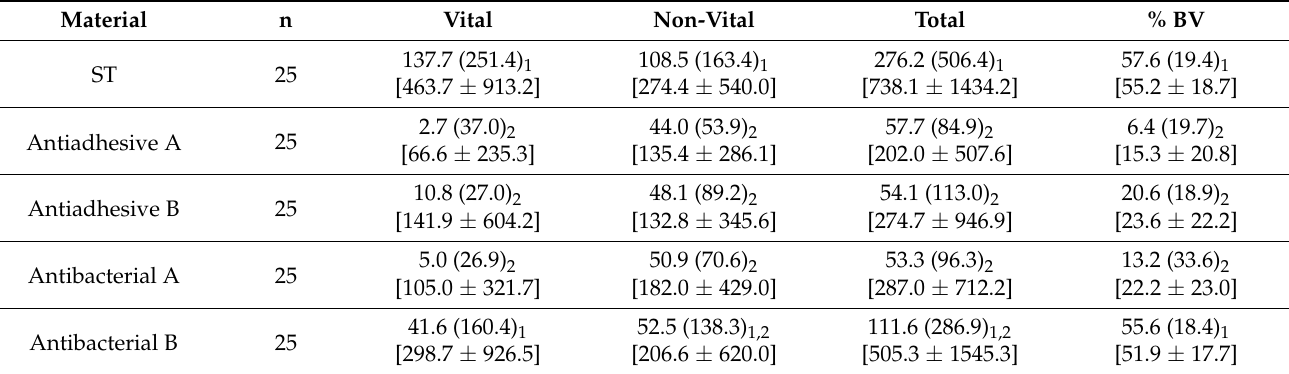
Table 4. Cell count medians (and interquartile ranges) of vital, non-vital, and total cells, and the bacterial cell viability ratio (BV). Means ± standard deviations are provided in square brackets. Values are rounded to valid digits. Equal subscript numbers within the columns indicate non- significant differences between the materials ( p > 0.05).